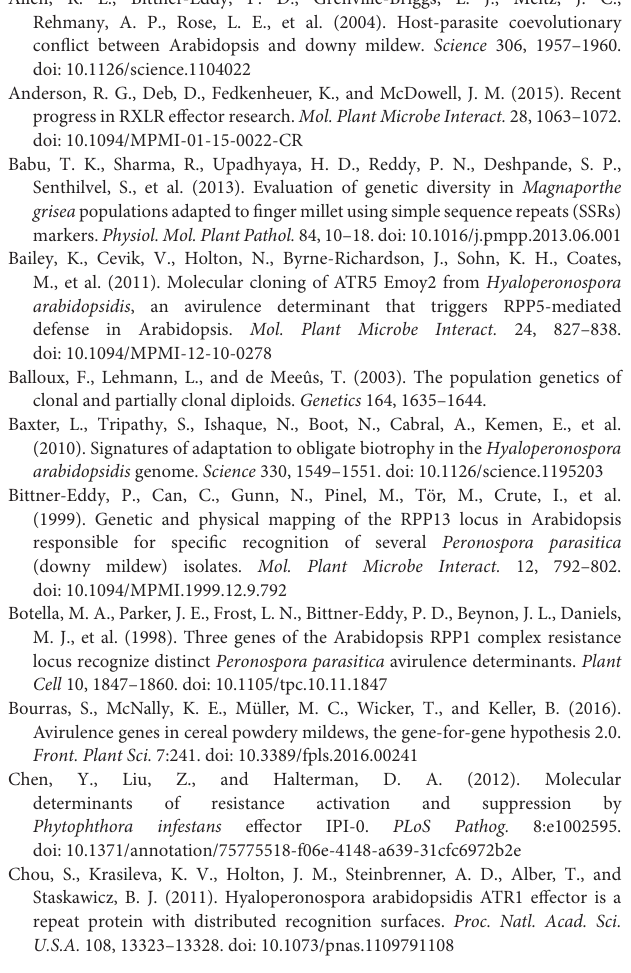
Supplemental Figure 5 | Alignment of nucleotide sequences of S-HAC1 Cala2 homologs from Hpa -Cala2, Hpa -Emoy2, and Hpa -Noks1. Supplemental Figure 6 | Expression analysis of HAC1 Cala2 and S-HAC1 Cala2 . Supplementary Table 1 | Primer sequences used in this study.